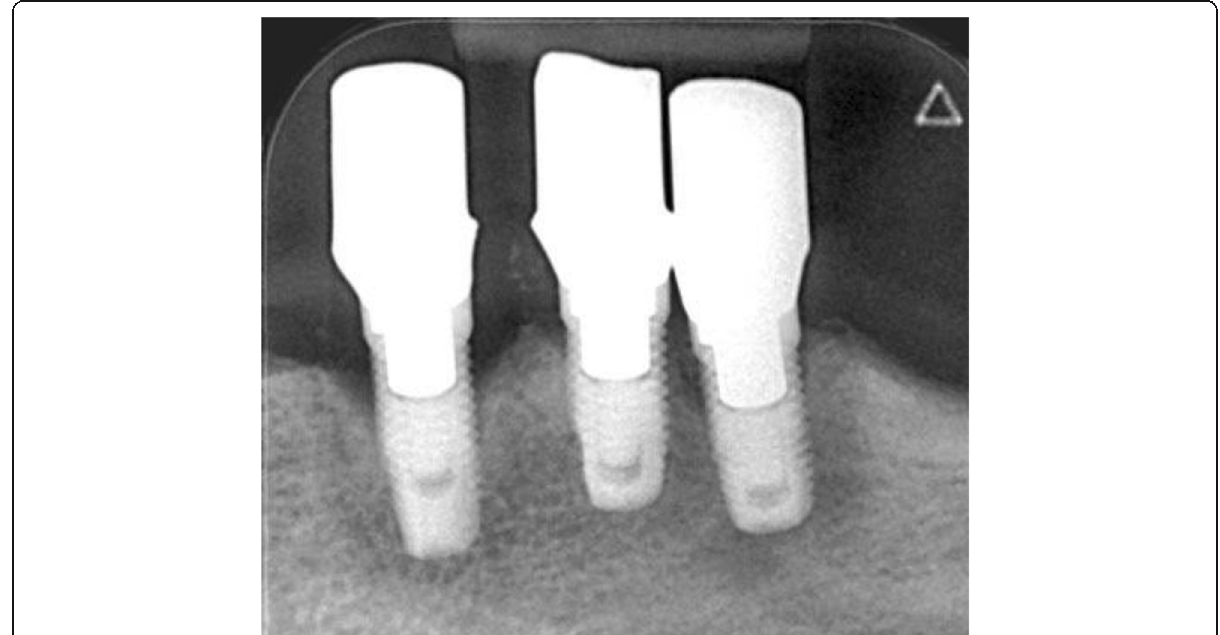
Fig. 4 The intraoral radiograph 7 years after insertion of the superstructure showed horizontal and vertical bone loss at all implants. At the implant in region 33, the mesial and distal crestal bone loss reached up to the 6th thread, at implant in region 34 to the 4th thread, and at the implant in region 35 to the 5th